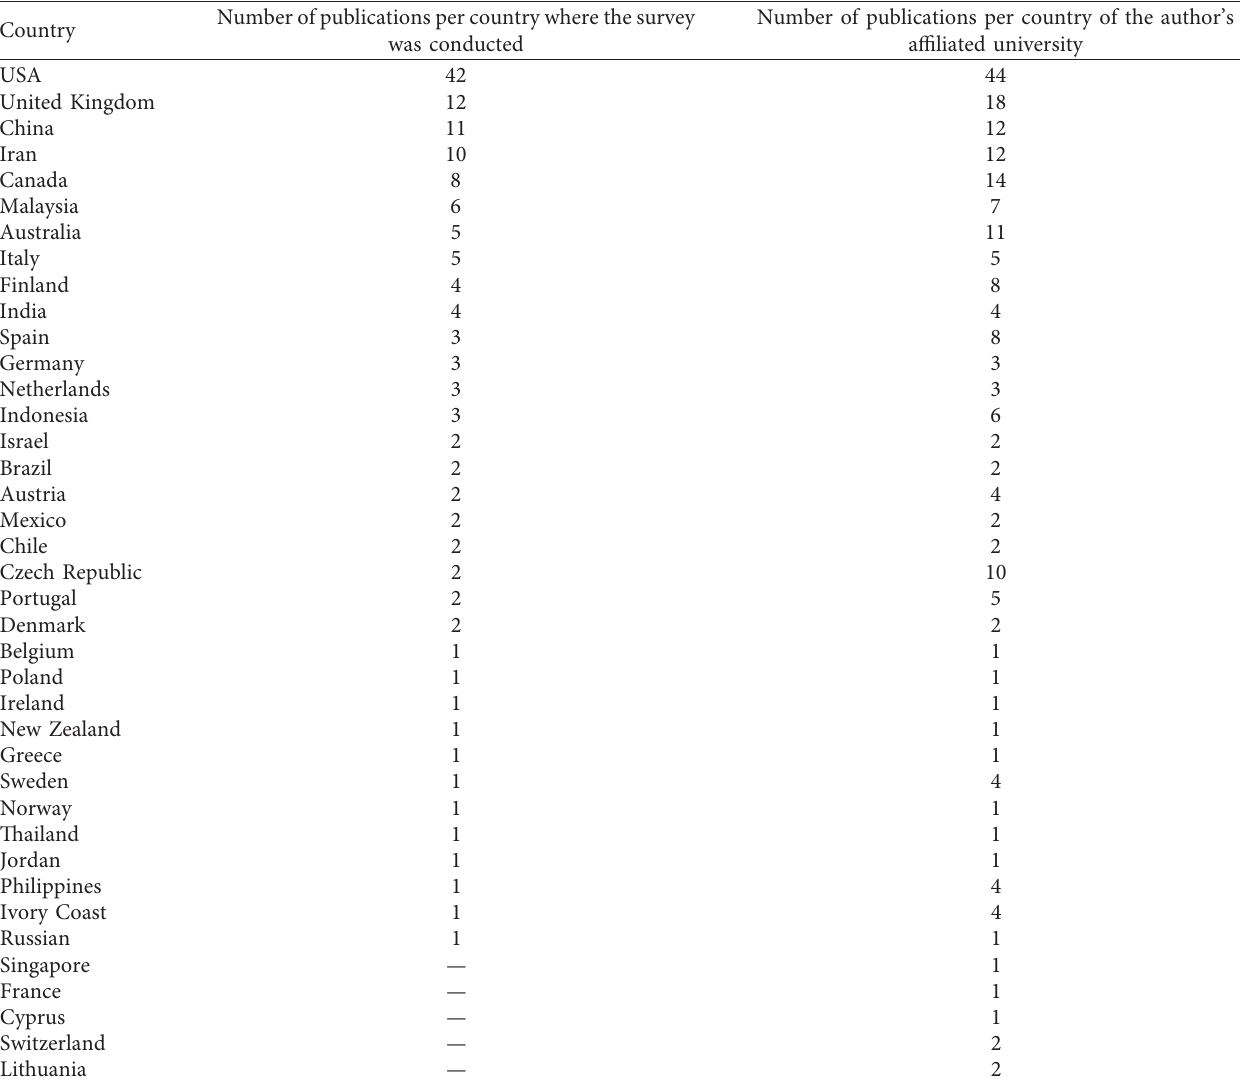
Table 3: Number of publications per country where the survey was conducted and per country of the author’s affiliated university